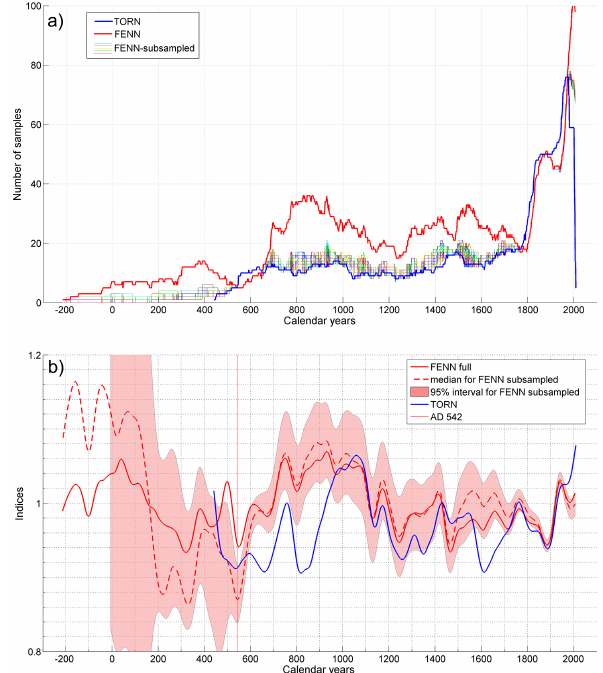
Figure 4. Replication of TORN, FENN and subsampled FENN data sets (a) and comparison of RC2SFC chronologies for different data sets (b) . Red shading shows the area between 2.5th and 97.5th per- centiles for FENN subsampled data sets. Vertical red line shows threshold for well-replicated data sets (more than five series). All series smoothed with 100yr splines. Variance and mean standard- ized to the period AD 1802–2006; 15yr smoothed data are used for variance adjustment.